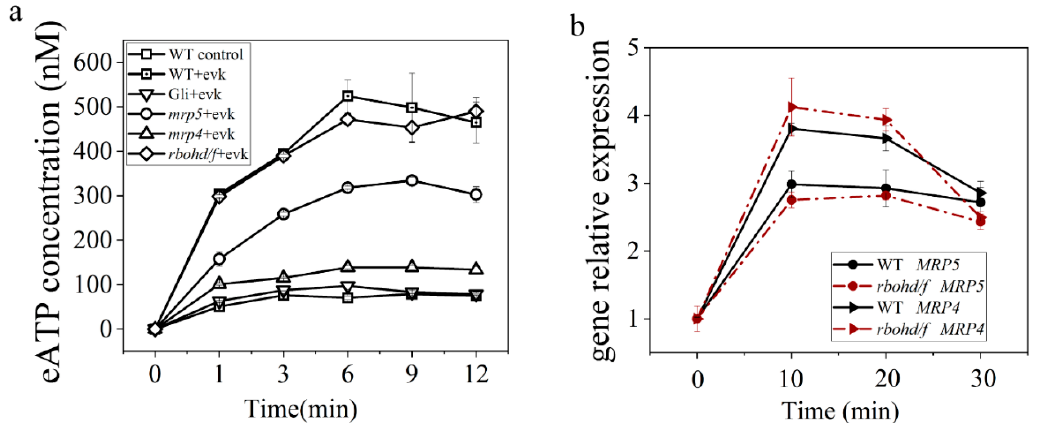
Figure 2. Evk-induced eATP accumulation requires MRP4 and MRP5, and H 2 O 2 may work down- stream of eATP signal. ( a ) The concentrations of eATP at different time points under evk soaking were measured in WT, Gli-treated WT group, mutants mrp4 , mrp5 and rbohd/f in 1 min, 3 min, 6 min, 9 min, 12 min. Evk increased secreting of eATP in seedling leaves of Arabidopsis while Gli reversed the evk-induced eATP elevation. MRP4 and MRP5 involed in evk-induced eATP accumulation. The accumulation of eATP induced by evk was not weakened in the mutant rbohd/f . Each group had six replicates. ( b ) Evk-enhanced the expressions of MRP4 and MRP5 were not weakened in the mutant rbohd/f . Each group had three replicates, and bars represented standard error of the mean. Error bars denote ± SEM, n ≥ 3.